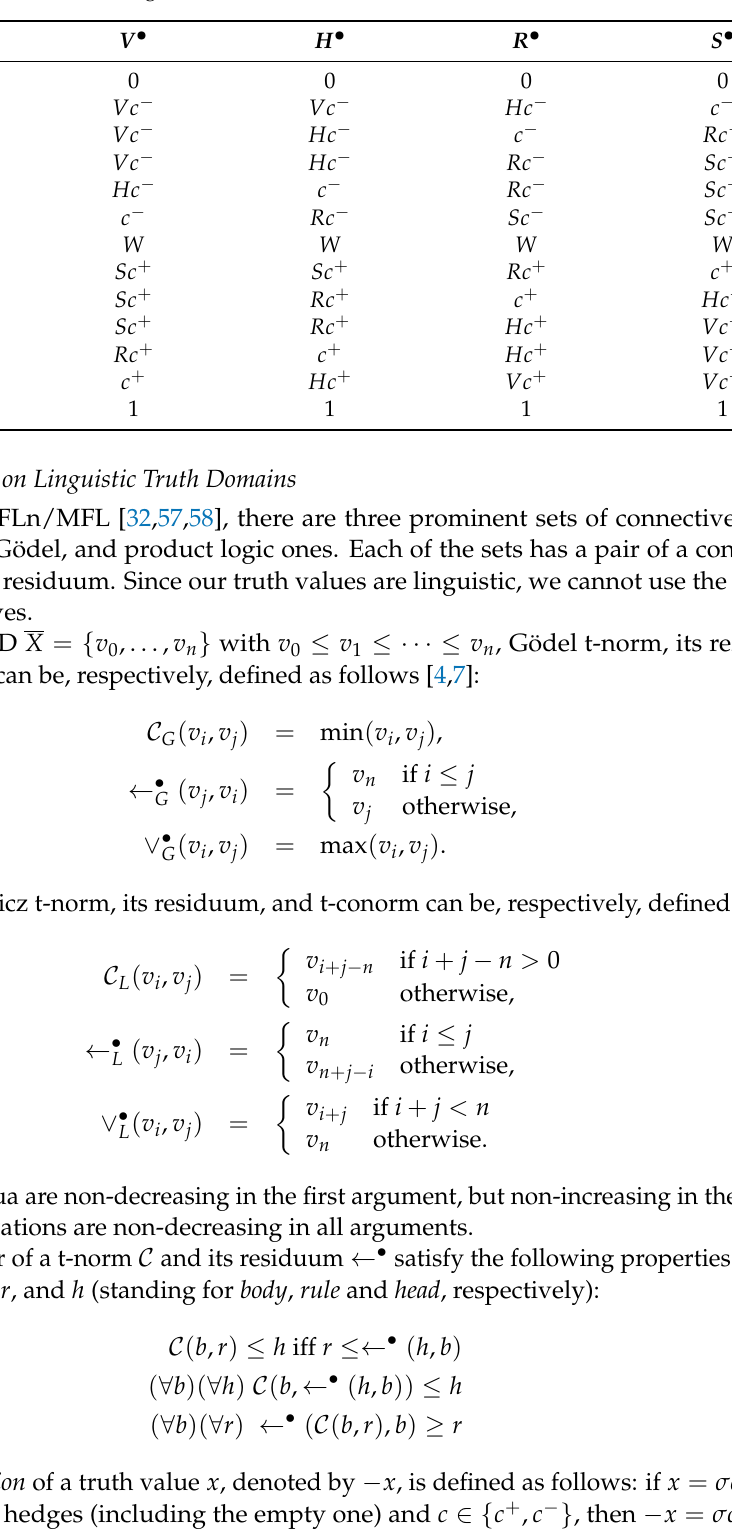
Table 1. Truth functions of hedge